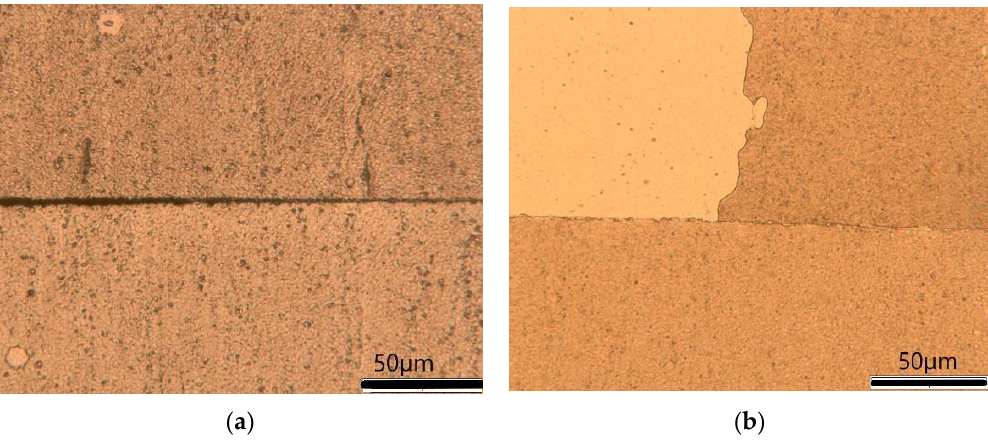
Figure 6. Metallographic observations of the interface in a joint made from two pieces with lapped surfaces, showing: ( a ) a poor-quality joint at lower temperature (950 °C) and ( b ) a good quality joint surfaces, showing: ( a ) a poor-quality joint at lower temperature (950 ◦ C) and ( b ) a good quality joint at at higher temperatures (1025 °C and 1050 °C). higher temperatures (1025 ◦ C and 1050 ◦